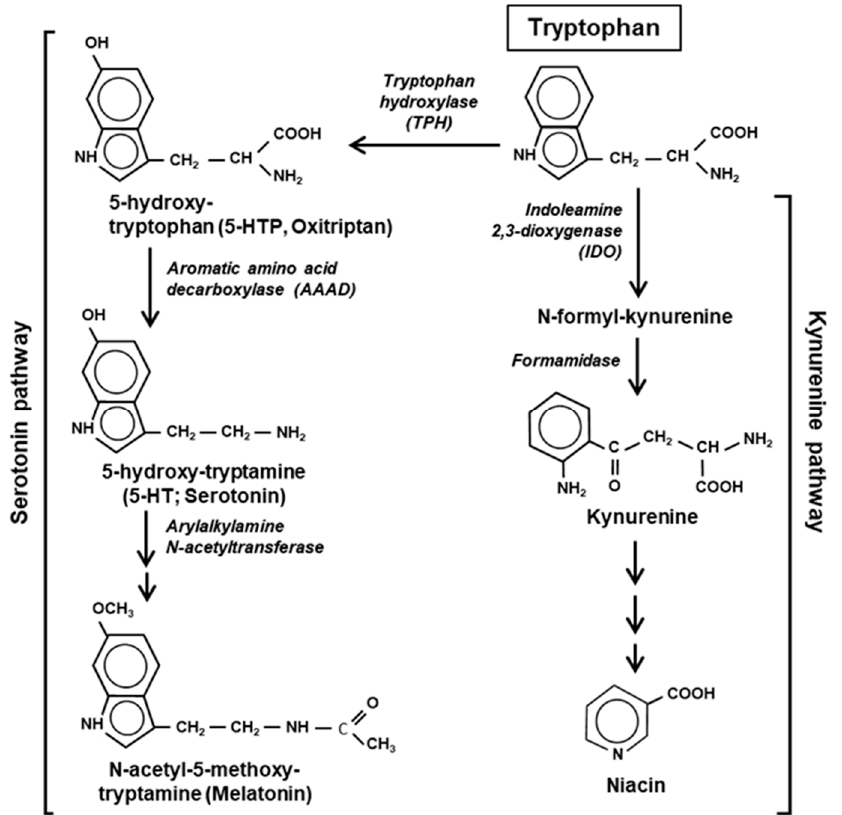
Figure 2. Two major pathways of Trp degradation. The serotonin and kynurenine pathways with their enzymes and products are shown. Note that the indole ring of Trp is destroyed at the very first step of the kynurenine but persists through the serotonin pathway.